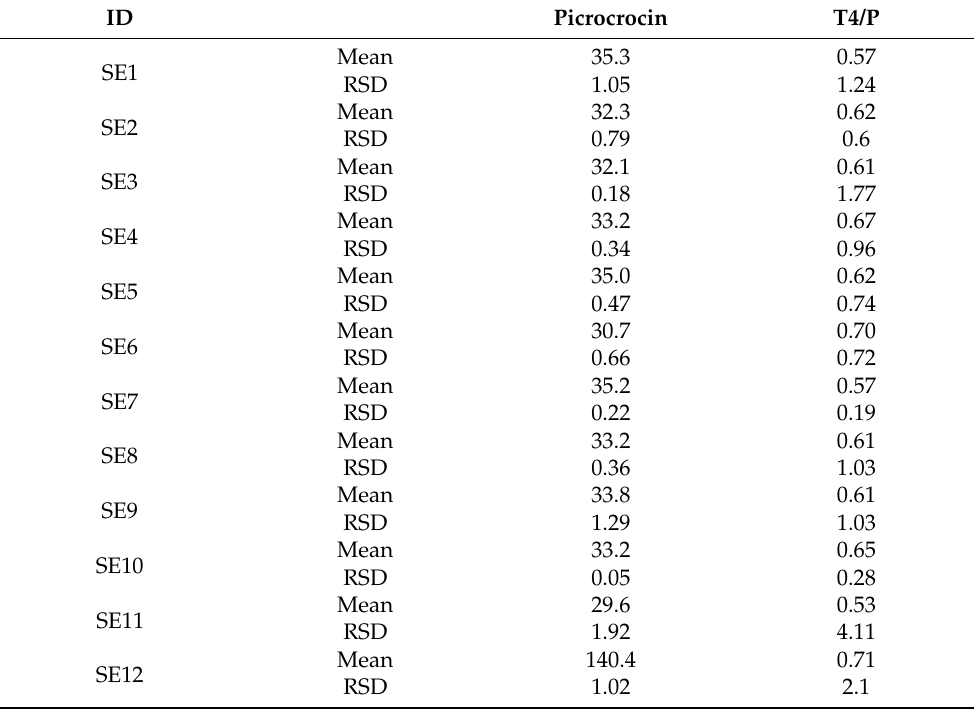
Table 4. Picrocrocin content (mg g − 1 ) and trans -4 GG/picrocrocin (T4/P) ratio for saffron extracts (SE), raw saffron stigmas (SS) and gardenia extract (GE). ND: non-detected.